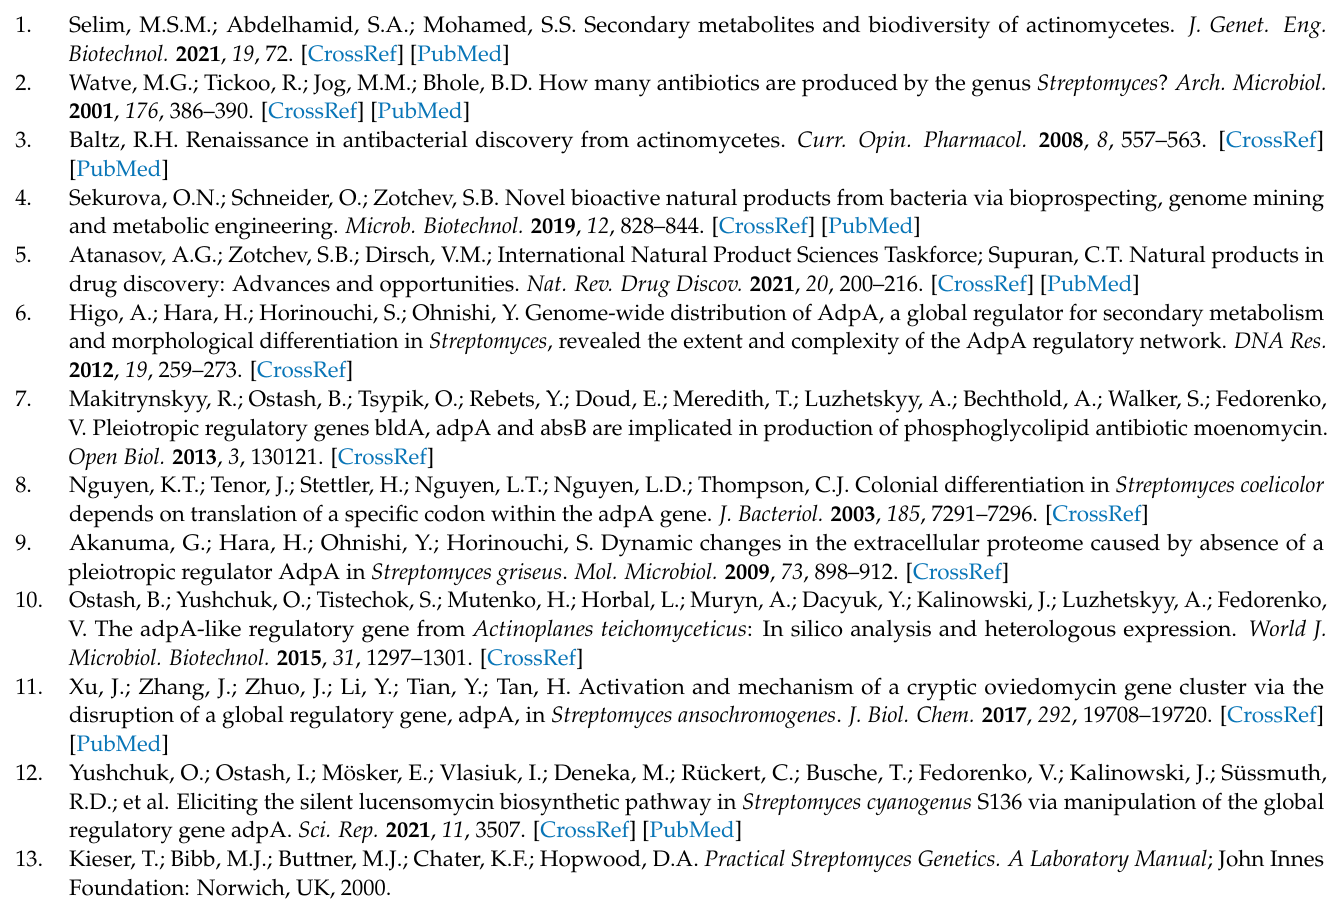
Streptomyces sp. Pv4-95 16S ribosomal RNA gene; Figure S2: Analyses of identified peaks in the crude extract of Streptomyces sp. Pv 4-95adpA strain. (A) Mass spectrum and (B) UV spectrum of identified peaks corresponding to flavacol (1), 3- β -hydroxy flavacol (2) and a compound that could not be obtained (3); Figure S3: 1 H NMR spectrum (MeOD- d4 , 500 MHz) of flavacol (1); Figure S4: 13 C NMR spectrum (MeOD- d4 , 125 MHz) of flavacol (1); Figure S5: 1 H NMR spectrum (MeOD- d4 , 500 MHz) of 3- β -hydroxy flavacol (2); Figure S6: 13 C NMR spectrum (MeOD- d4 , 500 MHz) of 3- β -hydroxy flavacol (2); Figure S7: 1 H- 1 H COSY spectrum (MeOD- d4 , 500 MHz) of 3- β -hydroxy flavacol (2); Figure S8: Edited-HSQC spectrum (MeOD- d4 , 500 MHz) of 3- β -hydroxy flavacol (2); Figure S9: HMBC spectrum (MeOD- d4 , 500 MHz) of 3- β -hydroxy flavacol